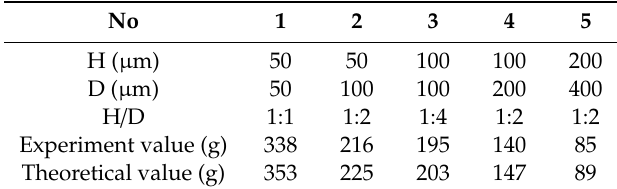
Table 2. Structure parameters of the test device ( µ m).